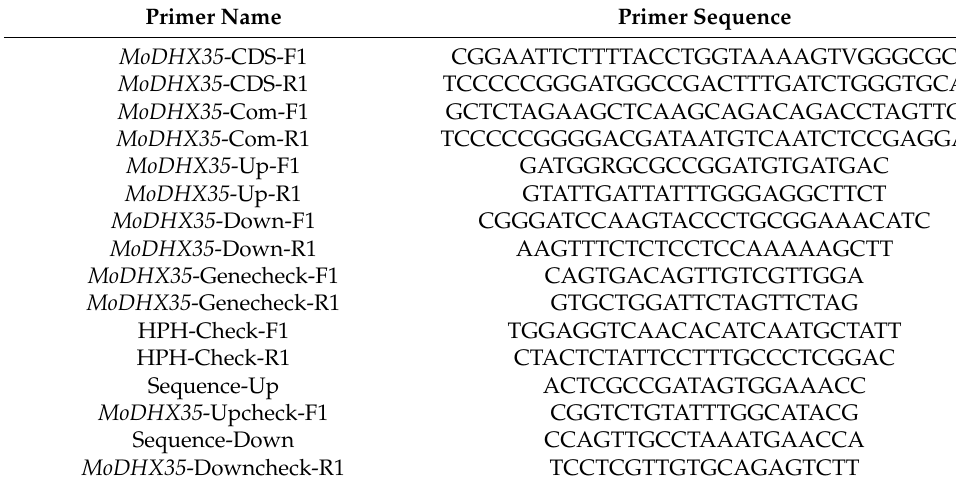
Table 2. The primers used in this